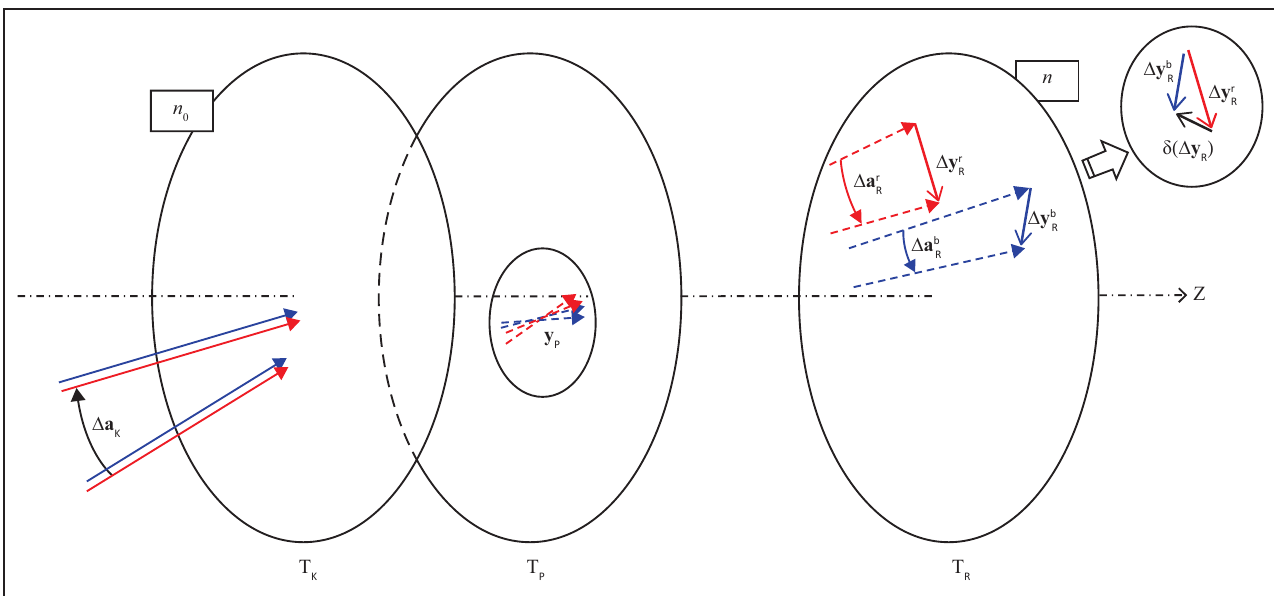
, pupillary T and retinal transverse planes T . A pencil of rays enters the eye at T K P R in T . The chromatic difference in image size δ ( ∆y P P and shown in the inset. Similarly, the chromatic difference in angular spread at the retina is δ ( ∆a R